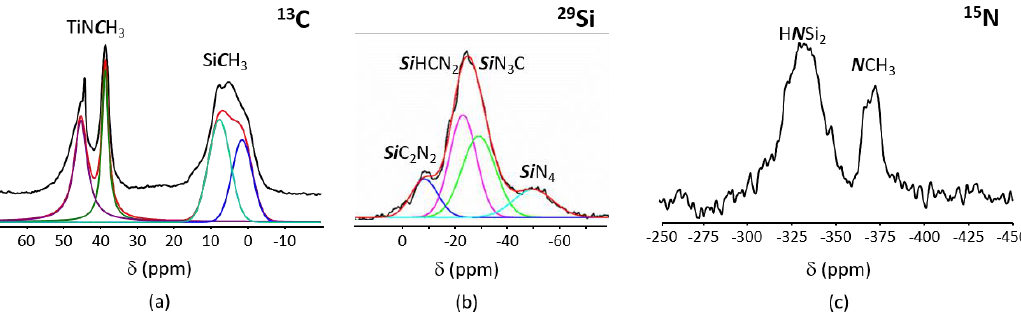
Figure 2. Experimental 13 C CP MAS NMR ( a ), 29 Si MAS NMR ( b ) and 15 N CP MAS NMR ( c ) spectra recorded for the PVMSZTi 2.5 sample at 7 T.